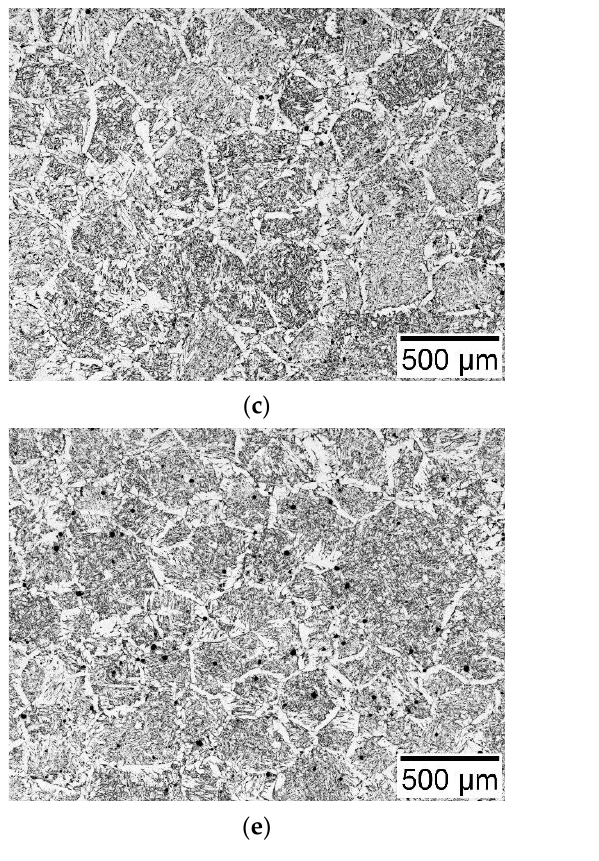
Figure 4. Optical images of the CGHAZ grain structures of ( a ) 2Ca, ( b ) 11Ca-1, ( c ) 11Ca-2, ( d ) 18Ca-1, ( e ) 18Ca-2 and ( f ) 25Ca steels after large-heat-input welding at 400 kJ cm − 1 . Figure 5 displays optical images showing the intragranular microstructures of the CGHAZs after large-heat-input welding at 400 kJ cm −1 . Fine and interlocking IAF is formed within the prior austenite grains of the CGHAZs of the HSLA steels regardless of the Ca content. The grain boundaries are completely enveloped by the coarse GBF, whose width is about 50 μ m. It is interesting that a small amount of ferrite side plate (FSP) is observed in the CGHAZs of the 2Ca and 11Ca-1 steels, in which the prior austenite grains are relatively coarse. This FSP grows inwardly from the grain boundaries, showing a comb-like morphology.